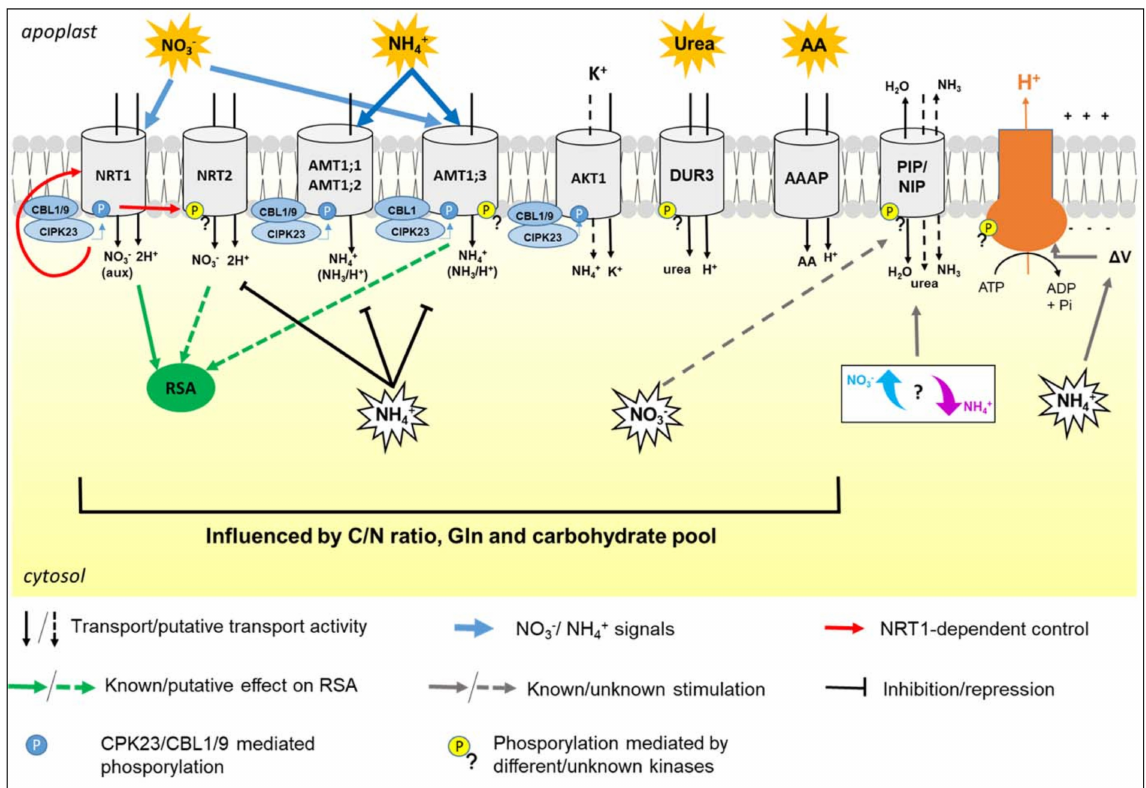
Figure 1. The figure summarizes the regulatory pathways and the metabolic relations among the main transporters involved in N uptake by roots, taking as a model Arabidopsis. For simplicity, transporters, transceptors, aquaporins, and H + -ATPase are reported in the same root cell, but it is not the common real case. Acronyms and details are explained in the